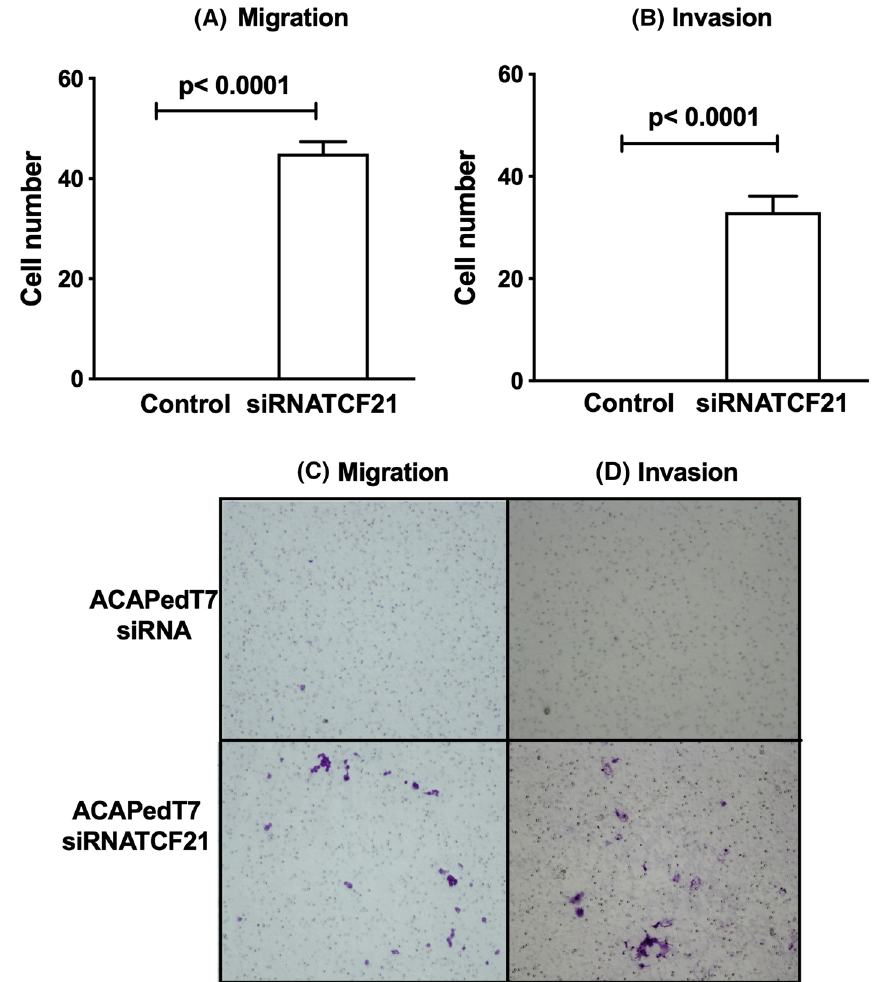
Fig. 4 Downregulation of TCF21 promote ACA migra- tion and invasion. A , C Migra- tion of ACAPed-T7siRNATCF21 cells in relation to control (ACAPed-T7siRNA); B , D Inva- sion of ACAPed-T7siRNATCF21 cells in relation to control (ACAPed-T7siRNA). The experiments were performed in triplicate and repeated three times. The results were expressed as the mean ± SD. Statistical significance was assessed by unpaired t